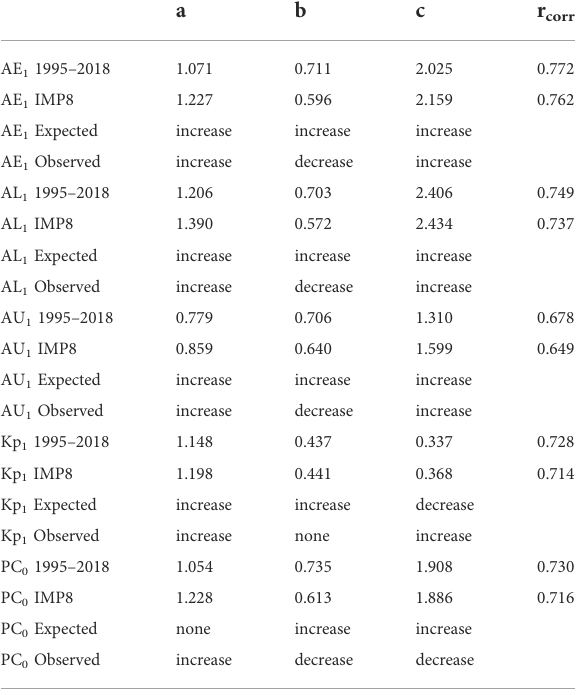
backward to noise values less than zero on sin( θ clock /2) in Figure 2 (thick curve with square points) would increase the a exponent (on v sw ) the most and also increase the b (on B sw ) and c [on sin( θ clock /2)] exponents.